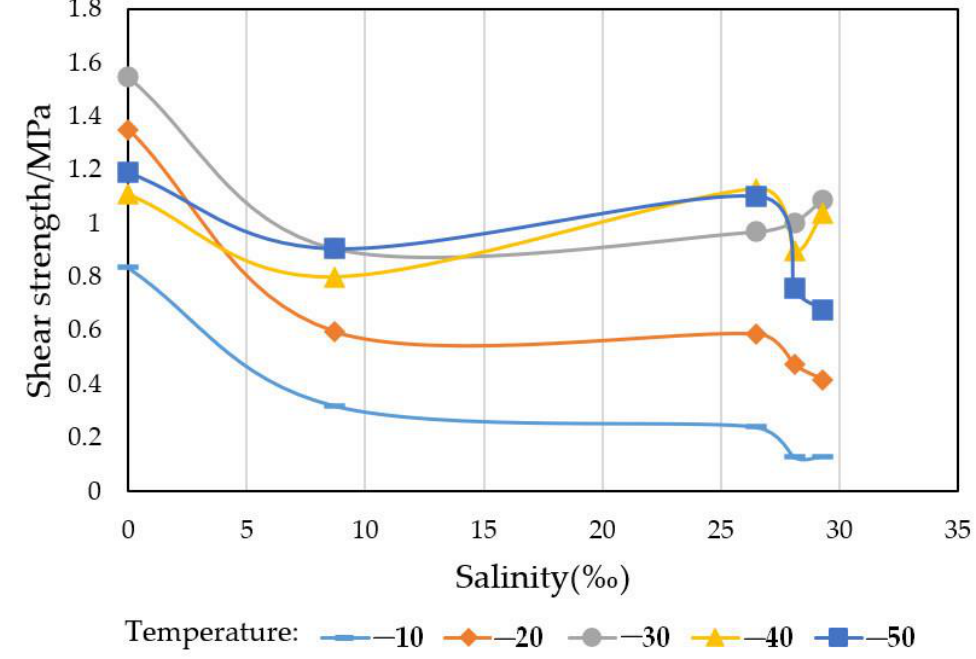
Figure 22. Shear strength and salinity. Figure 21. Shear strength and